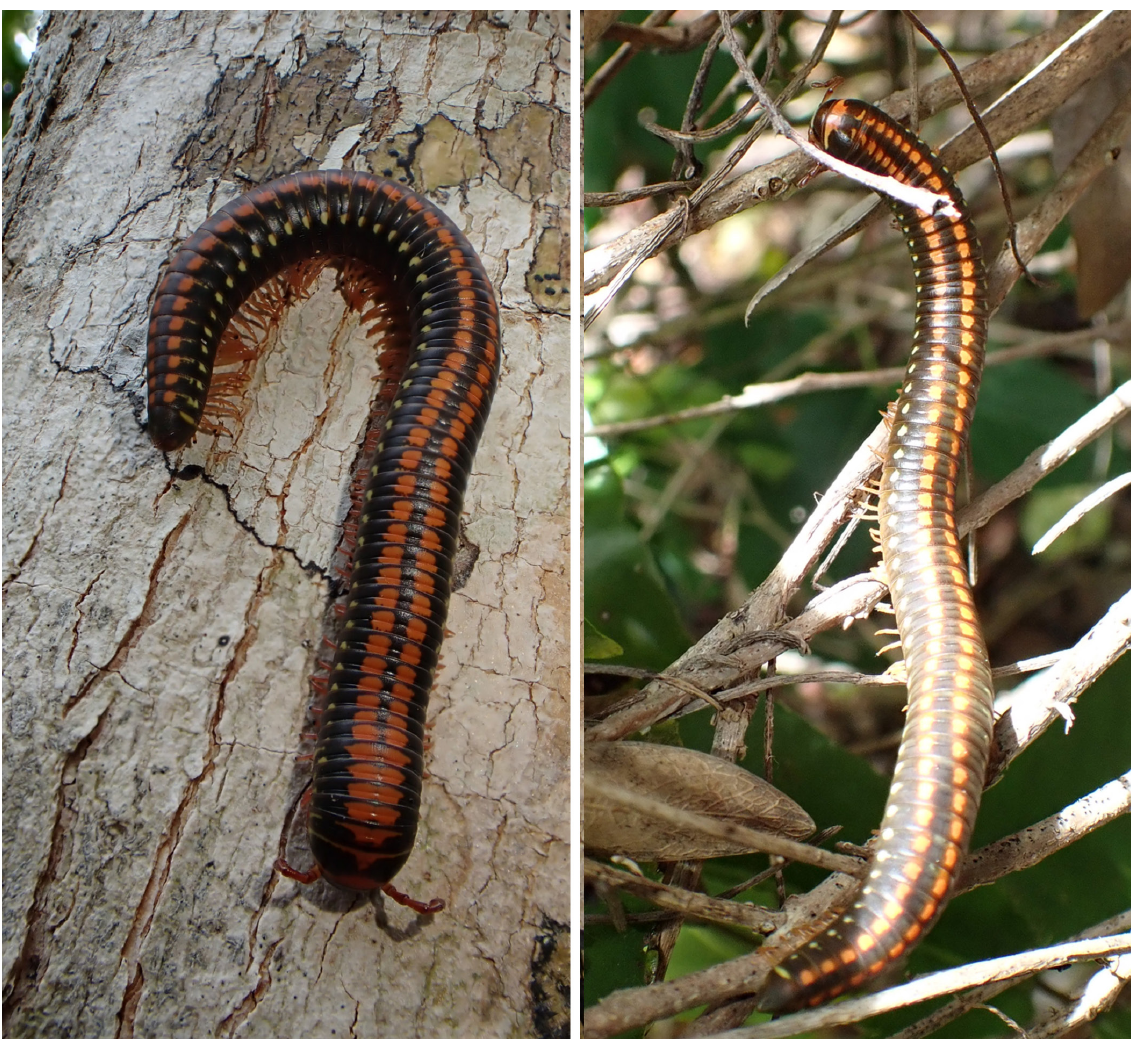
Fig. 12. Callistodontopye latifolia (Attems, 1914), two specimens (not collected) from Tanzania, small island at Kwale in Manza Bay, to show the compact body shape and bright colour pattern characteristic of thegenus Callistodontopyge . Photo Claudia